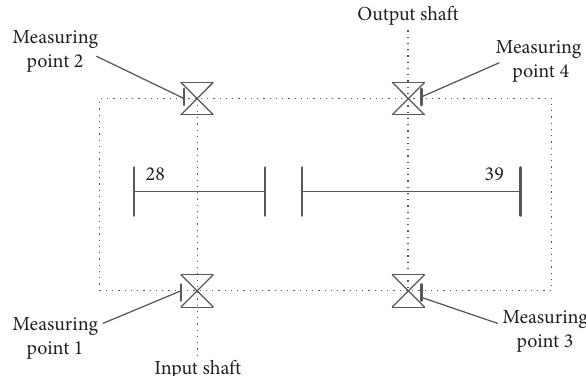
Figure 13: Gearbox structure and measuring points.